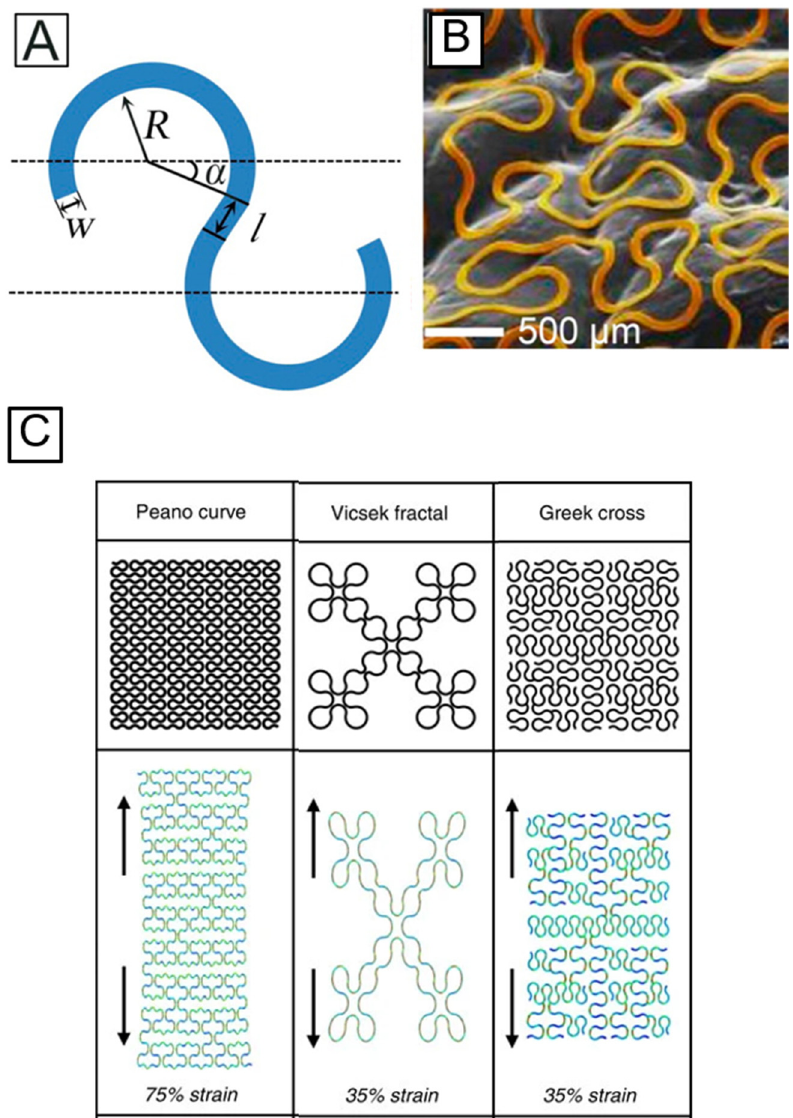
Figure 6. Representative geometrical configurations for hard–soft material integration. ( A ). Schematic representation of a serpentine unit cell. ( B ). Example of serpentine structured traces on an electrode array [91]. Reprinted with permission from Ref. [91]. Copyright 2015. American Chemical Society. ( C ). Different patterns of fractal-inspired layouts of metal wires (top), and FEM images of each structure under elastic tensile strain [90]. Reprinted with permission from Ref. [90]. Copyright 2014 Nature Publishing Group.